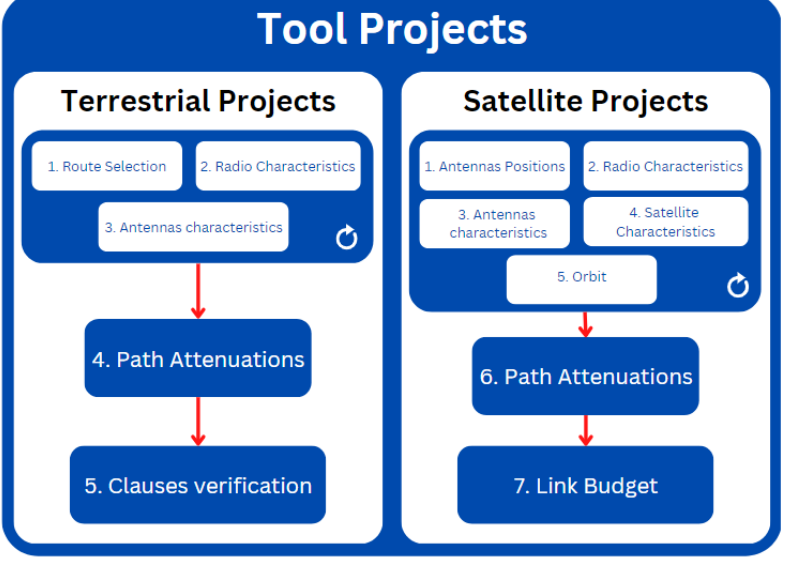
Figure 1. Developed Tool